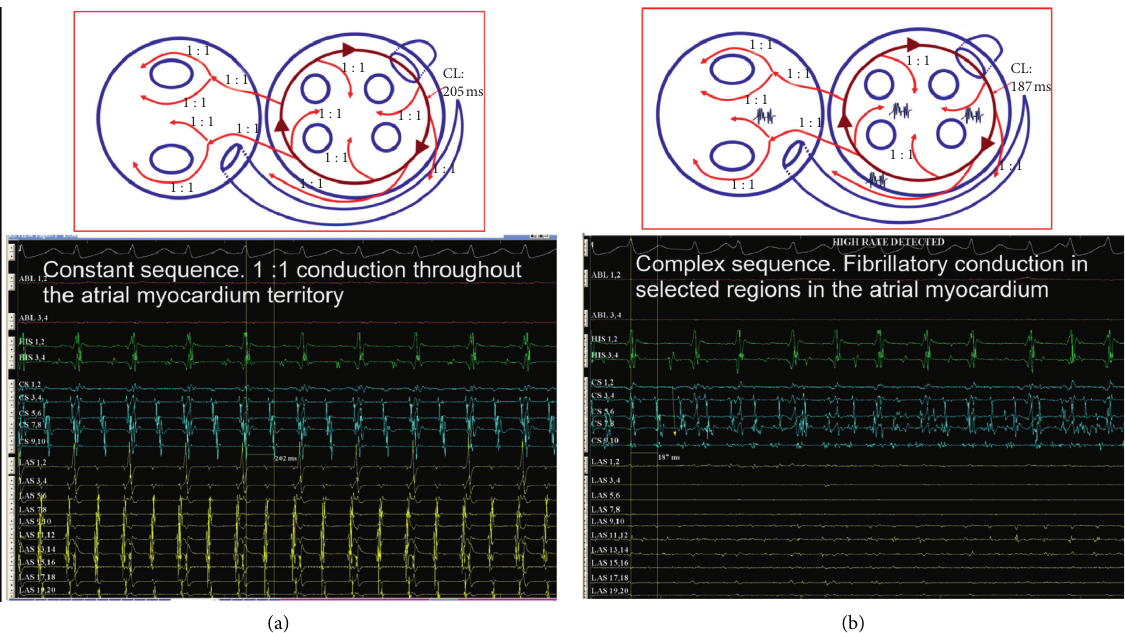
Figure 8: The hypothetical mechanism of the occurrence of fibrillatory conduction in macrocircuits, studied by the technique of selective activation remapping. (a) Clockwise perimitral flutter with 205ms CL and constant 1:1 conduction throughout the atria (regular atrial tachycardia). (b) Acceleration of the CL to 187ms with fibrillatory conduction (unstable atrial tachycardia) (from Ioannidis et al.